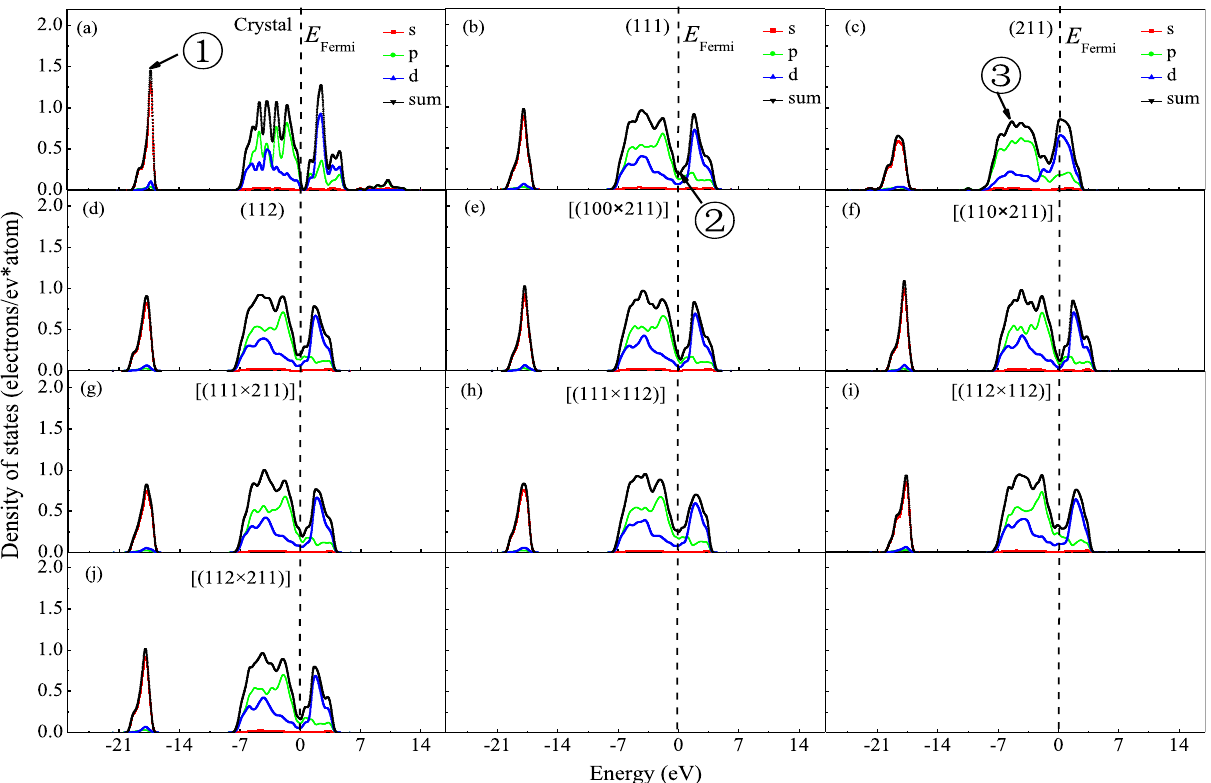
Figure 3. Partial density of states of MnO 2 crystal, bulk surface and microfacet